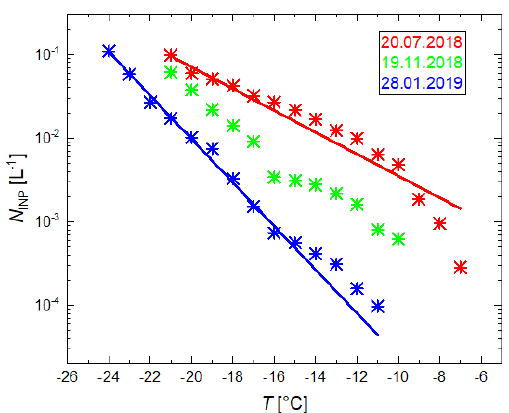
Figure 2. Three exemplary INP spectra together with fits based on exponential decay, with a slope of − 0 . 6 for the sample with sam- pling end date of 28 January 2019 and − 0 . 3 for the sample with sampling end date of 20 July